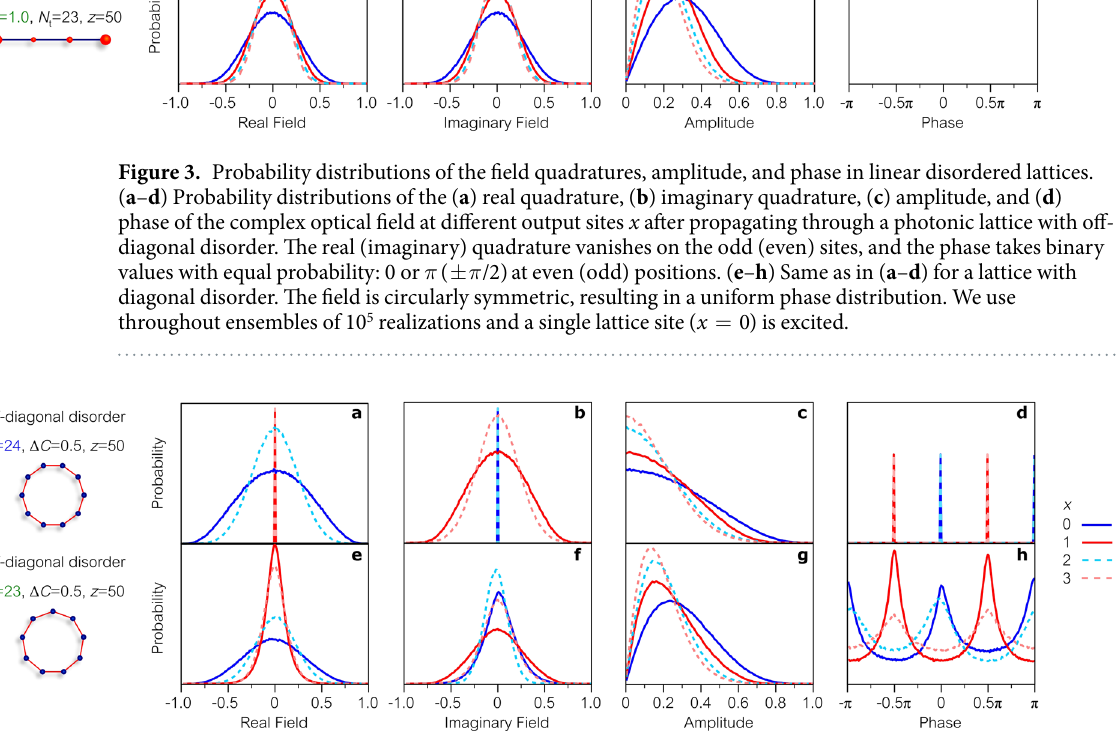
Figure 4. Probability distributions of the field quadratures, amplitude, and phase in ring lattices with off- diagonal disorder. ( a – d ) Probability distributions of the ( a ) real quadrature, ( b ) imaginary quadrature, ( c ) amplitude, and ( d ) phase of the complex optical field at different output sites x after propagating through an even -sited ring lattice. The real (imaginary) quadrature vanishes on the odd (even) sites, and the phase takes binary values with equal probability: 0 or π π ± ( /2) at even (odd) positions. ( e – h ) Same as in ( a – d ) for an odd - sited ring lattice. ( g ) Amplitudes of the fields take Rayleigh-like distributions. ( h ) Phase distributions reflect an intermediate stage between discrete and uniform probability